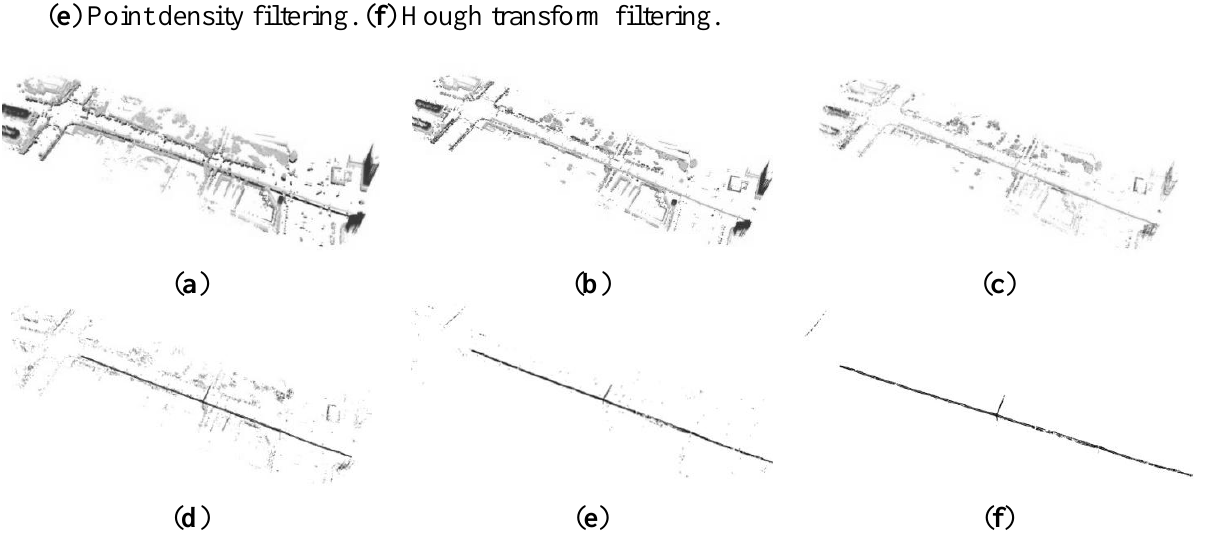
Figure 9. Power line extraction procedures. ( a ) Ground truth points filtering. ( b ) Terrain clearance filtering. ( c ) Up-down continuity filtering. ( d ) Feature eigenvector filtering. ( e ) Point density filtering. ( f ) Hough transform